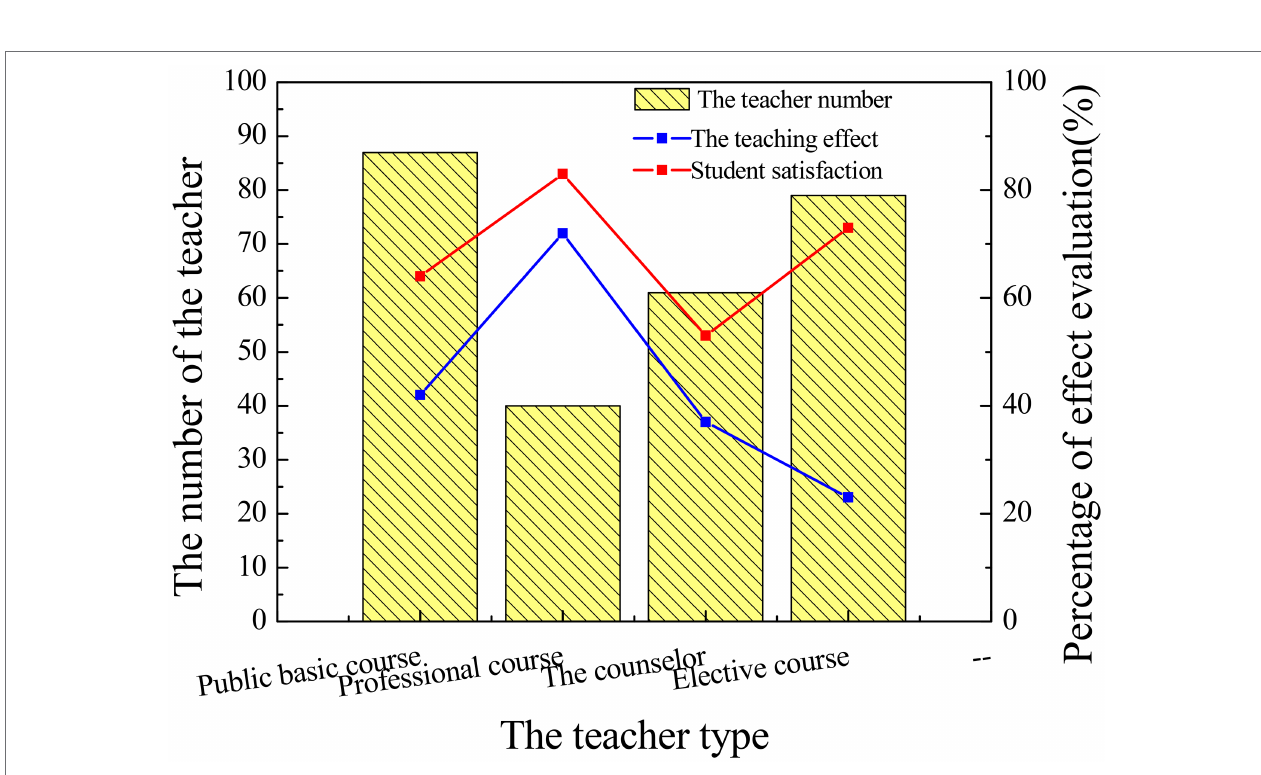
FIGURE 6 | Comparison of the number of teachers offering entrepreneurship education and the proportion of excellent teaching effect